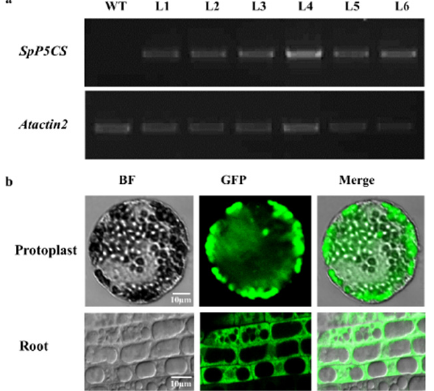
Figure 3. RT-PCR identification of SpP5CS and the subcellular localization of the 35S: SpP5CS -GFP fusion protein. ( a ) The RT-PCR identification of lines 1-6 of OE-SpP5CS A. thaliana ; ( b ) Subcellular localization of the 35S:SpP5CS-GFP fusion protein in the root tips and leaf mesophyll protoplasts of transgenic A. thaliana .